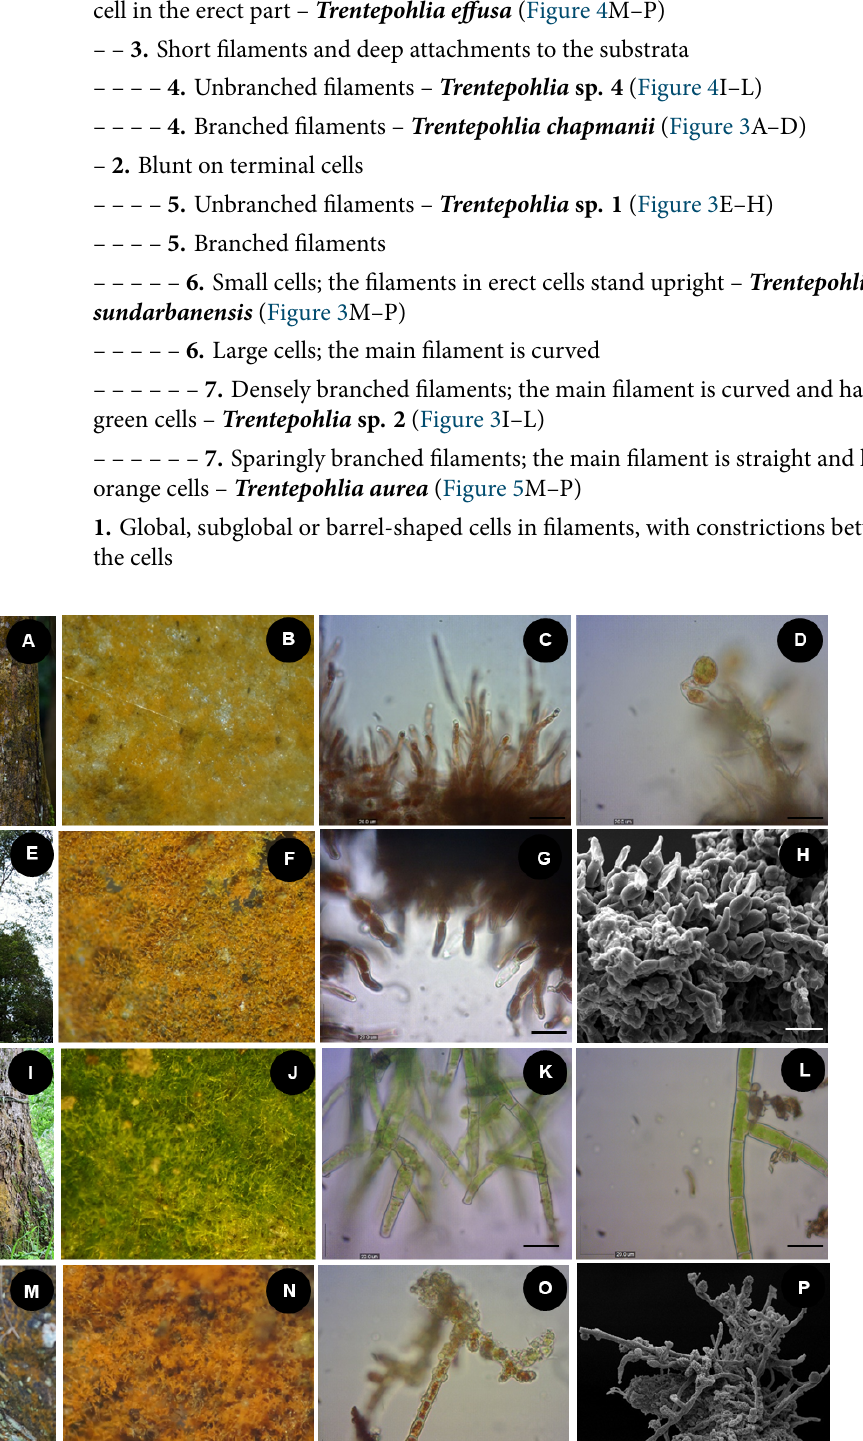
ActaSocietatisBotanicorumPoloniae /2020/Volume89/Issue1/Article8912 Publisher: